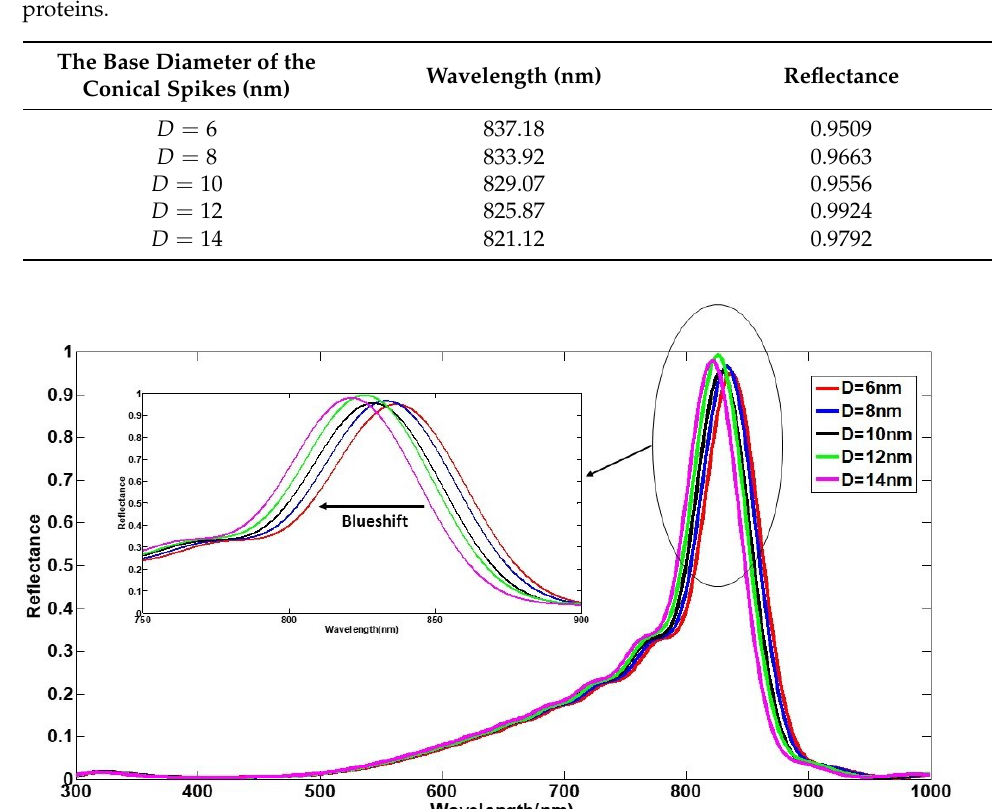
Figure 6. The simulated reflectance spectra of the COVID-19 particle model under changing the base diameter of COVID’s spikes. The values of the remaining geometric parameters defining the COVID-19 particle were r = 70 nm, h = 20 nm, and N =